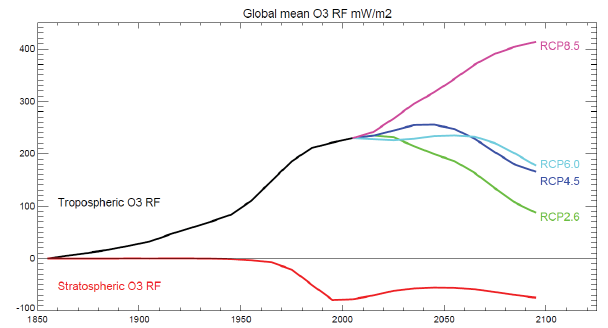
Fig. 17. Evolution (1850–2100) of decadal mean global average ozone radiative forcing, shown for tropospheric ozone (black up to 2000s) and stratospheric ozone (red). Beyond the 2000s, four different scenarios for tropospheric ozone precursor emissions are followed: RCP 2.6 (green), RCP 4.5 (blue), RCP 6.0 (cyan) and RCP 8.5 (magenta). The stratosphere follows a single scenario: the A1 adjusted halogen loading scenario, and is the average of results from 13 CCMs that performed the REF-B2 scenario of CCMVal-2 (this follows the SRES A1B climate